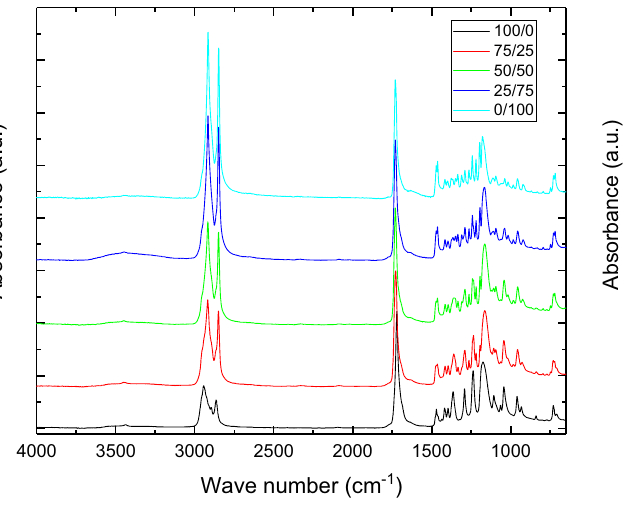
Figure 3: FTIR spectra of polyesters and copolyesters form CL – PDL synthesized by MW - assisted ROP catalyzed by N435.